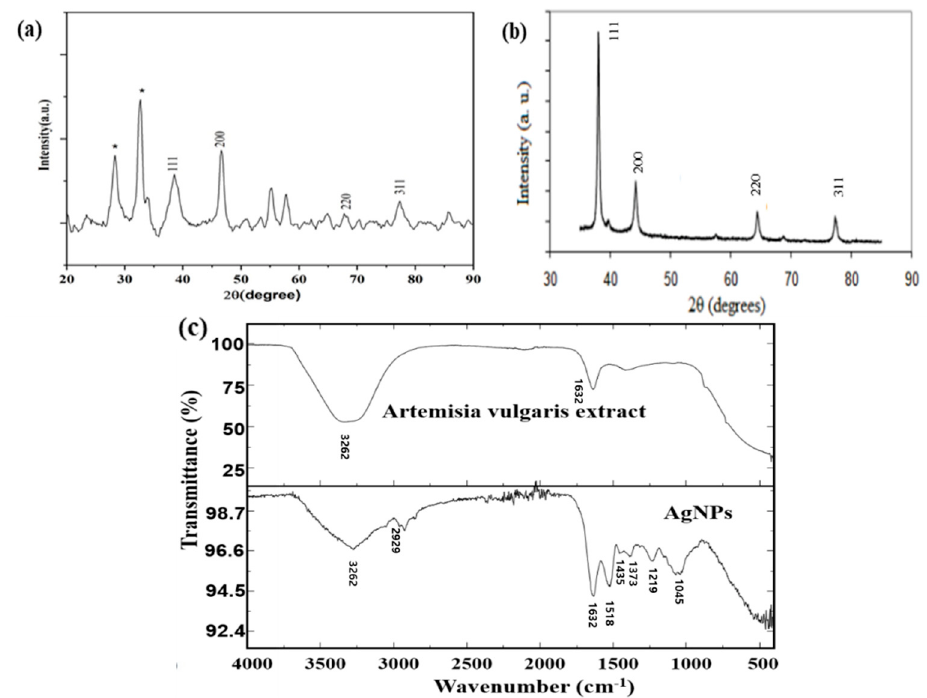
Figure 3. ( a ) XRD pattern of Artemisia vulgaris -mediated AgNPs, ( b ) XRD pattern of AgNPs [28], and ( c ) FTIR spectra of Artemisia vulgaris extract and AgNPs.